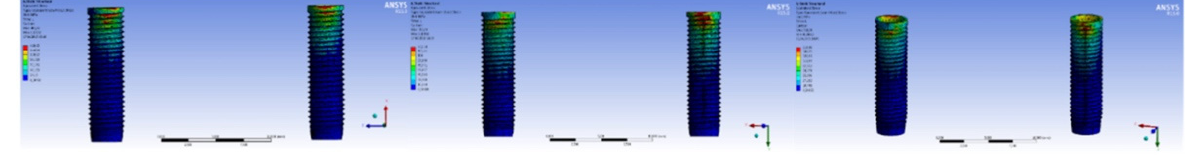
Figure 5. The Von Mises stress distribution on Model 1, Model 2 and Model 3 implants after horizontal loading.